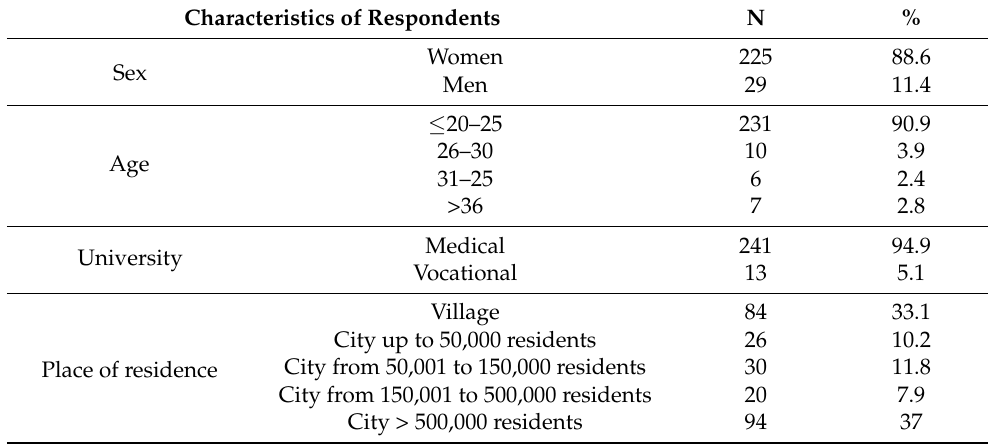
Table 1. Students’ characteristics (N =